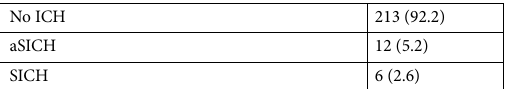
Table 1. Baseline characteristics and outcome of enrolled patients. Data are means ± SD or medians (interquartile ranges). aSICH, asymptomatic intracerebral hemorrhage; APTT, activated partial thromboplastin time; ASPECTS, Alberta Stroke Program Early CT Score; BMI, body mass index; ECASS II, European Co-operative Acute Stroke Study-II; hsCRP, high sensitivity C-reactive protein measurement;